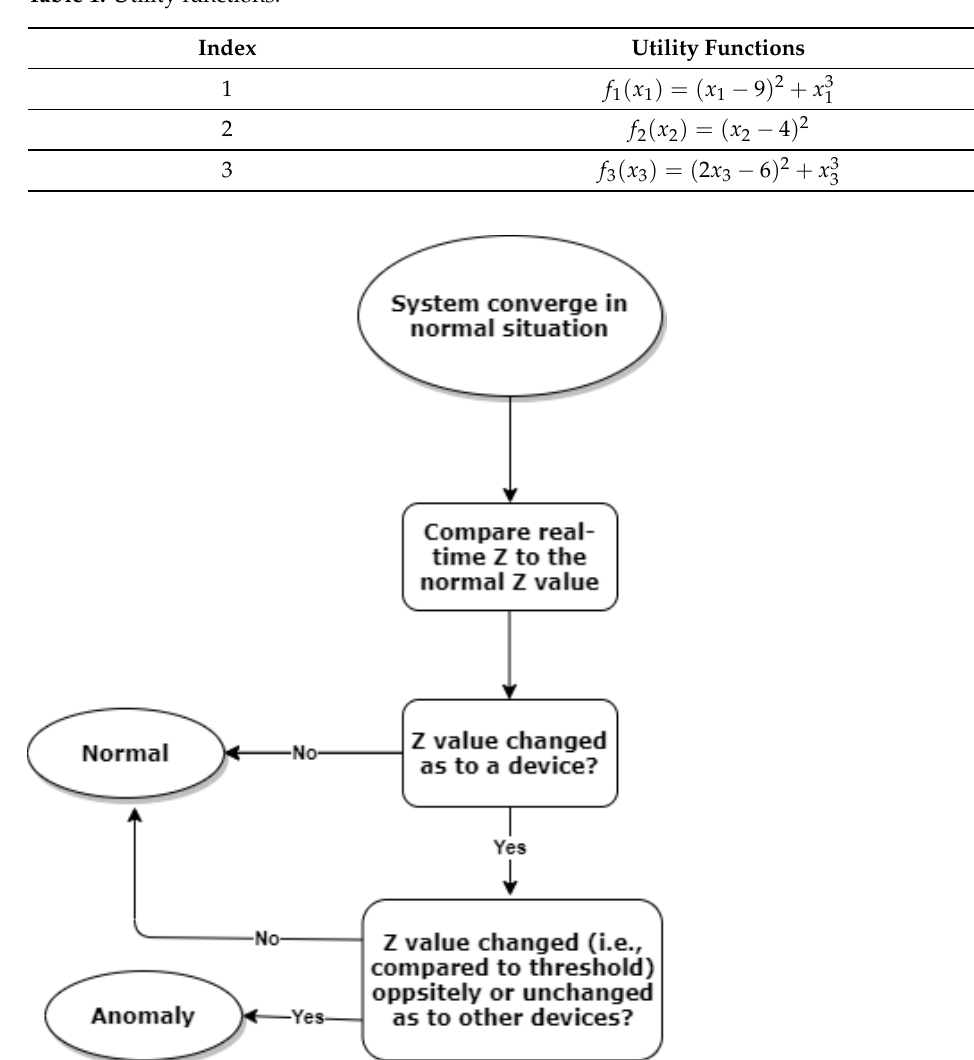
Figure 4. The proposed rule-based detection